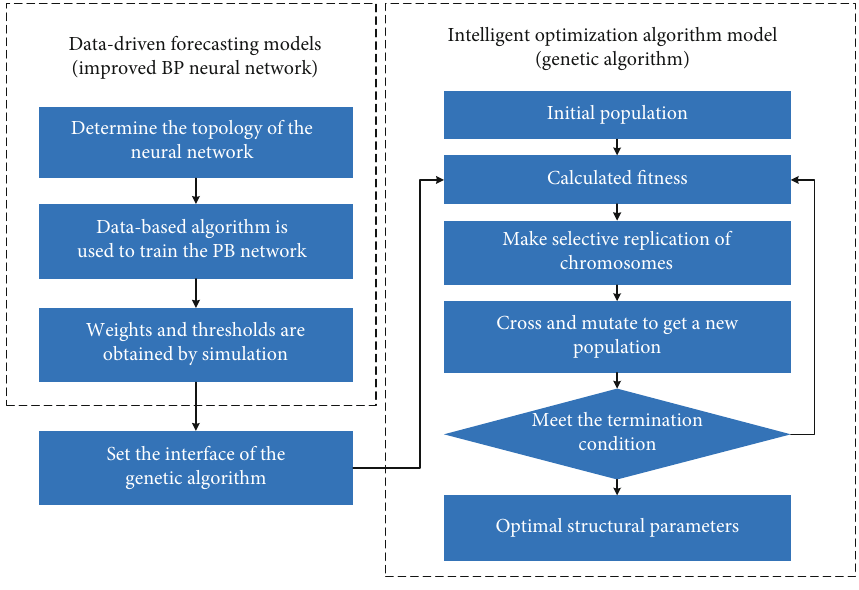
Figure 9: Flow diagram of the optimization method.